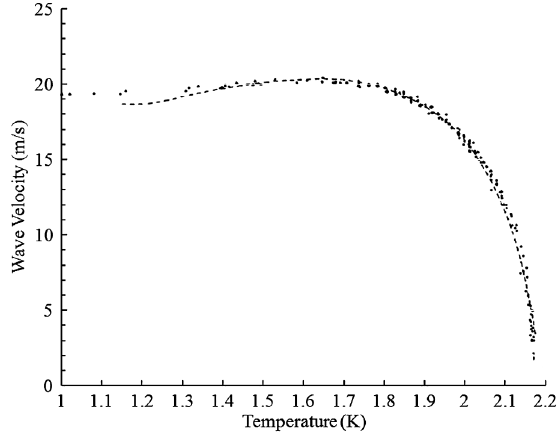
FIG. 2. Second sound velocity versus